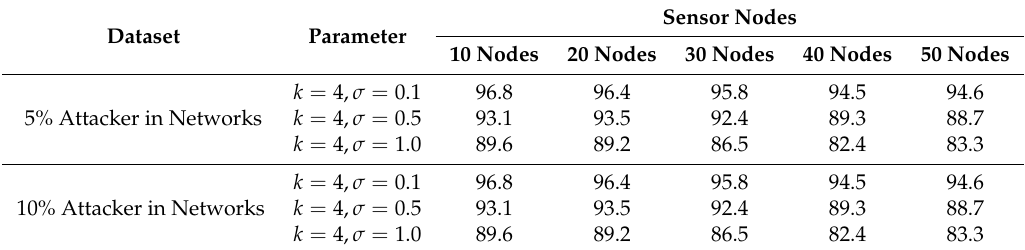
Table 5. Average detection accuracy for five sensor nodes scales by the SCDNN algorithm using optimal k and sigma values (%).